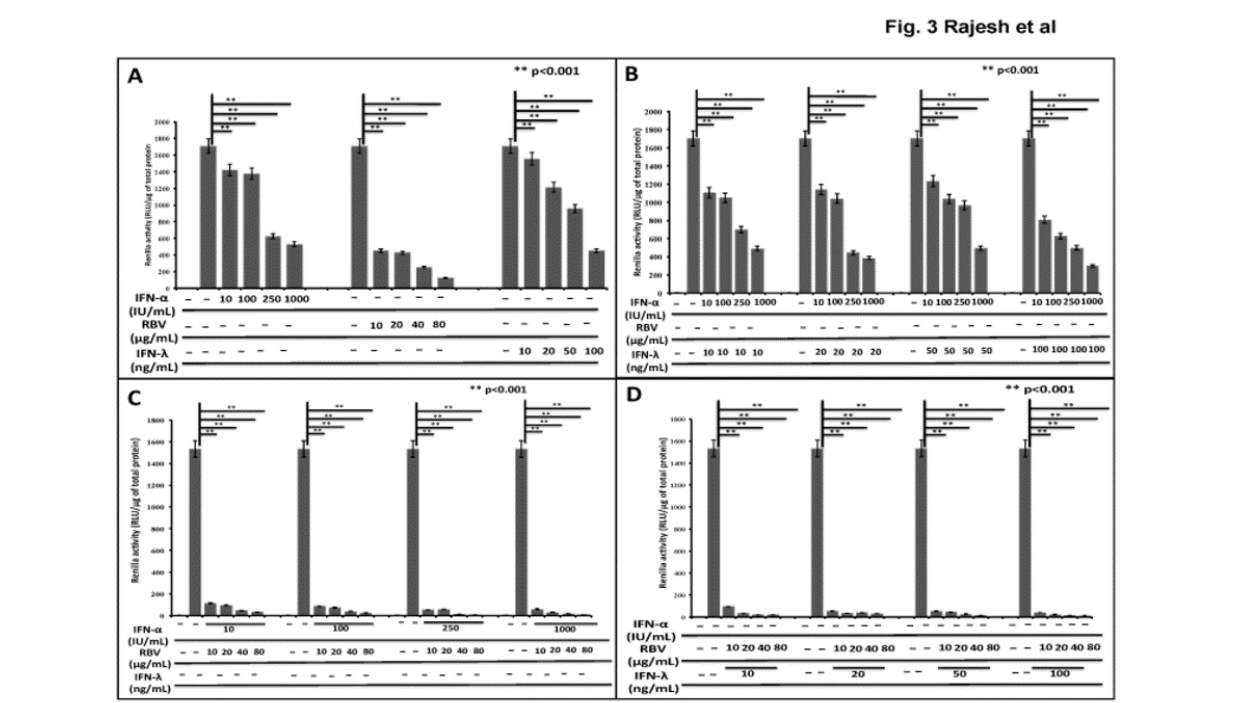
Figure 3. Different combinations of IFN-α, RBV, and IFN-λ inhibits HCV IRES Rluc mediated translation. Huh-7 cells were infected with T7-expressing adenovirus. After 2 hrs, HCV IRES-RLuc plasmid was transfected and then treated with indicated concentration of IFN-α, IFN-λ and RBV. The concentration dependent inhibition of Renilla luciferase activity by ( A ) IFN-α, RBV, and IFN-λ single treatment;( B ) Combination of IFN-α + IFN-λ; ( C ) Combination of IFN-α + RBV and ( D ) Combination of IFN-λ + RBV. doi: